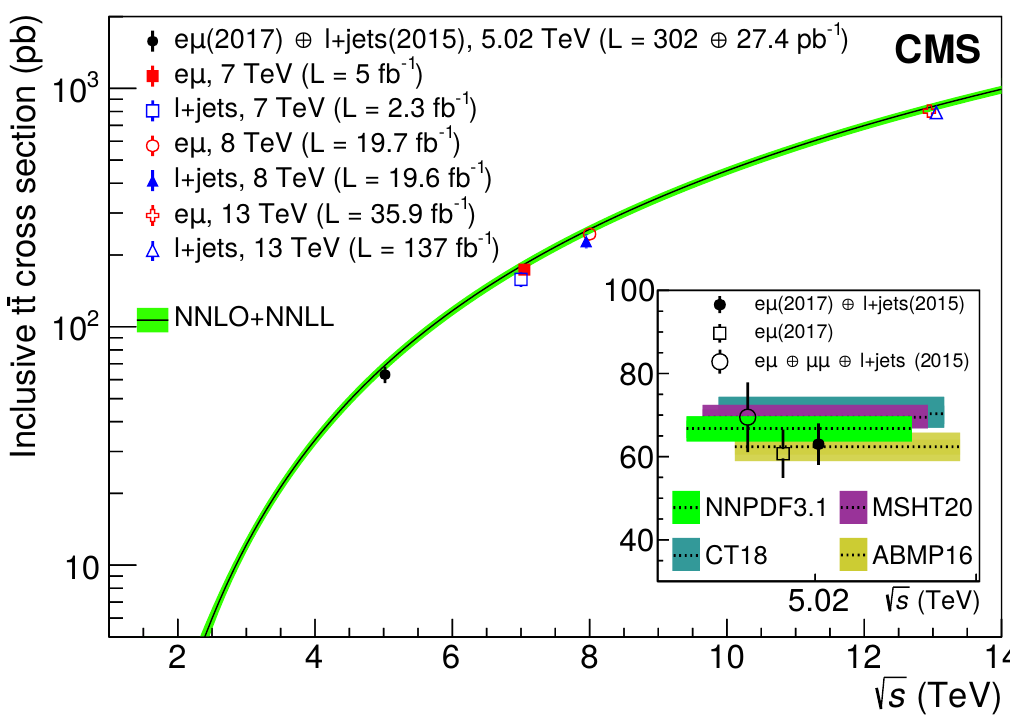
Figure 2 . Inclusive tt cross section in pp collisions as a function of the center-of-mass energy in the separate ‘ +jets and dilepton channels along with the combined measurement at 5.02 TeV √ presented in this analysis are displayed. Some of the previous CMS measurements at s = 7 , 8 [6, 7], and 13 TeV [2, 11] are also shown. The NNLO+NNLL theoretical prediction [27] using the NNPDF3.1 [23] PDF set with α ( m ) = 0 . 118 and m = 172 . 5 GeV is shown in the main plot. In S Z t the inset, predictions at 5.02 TeV using the MSHT20 [48], CT18 [49], and ABMP16 [50] NNLO PDF sets, the latter with α ( m ) = 0 . 115 and m = 170 . 4 GeV, are compared, along with the NNPDF3.1 S Z t NNLO prediction, to the individual and combined results from this analysis. The vertical bars and bands represent the total uncertainties in the data and in the predictions, respectively. Points √ corresponding to measurements at the same s are horizontally shifted for better